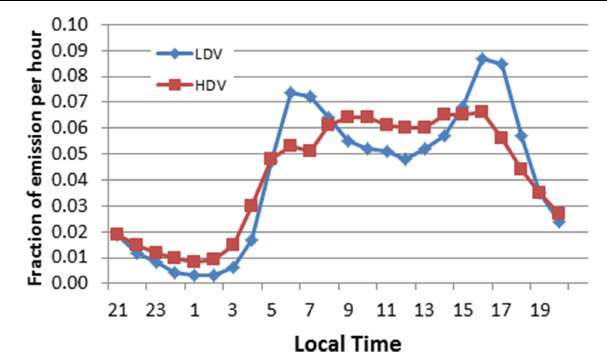
FIGURE 7 | Temporal distribution of emissions for light-duty vehicles (LDV, including motorcycles) and heavy-duty vehicles (HDV).